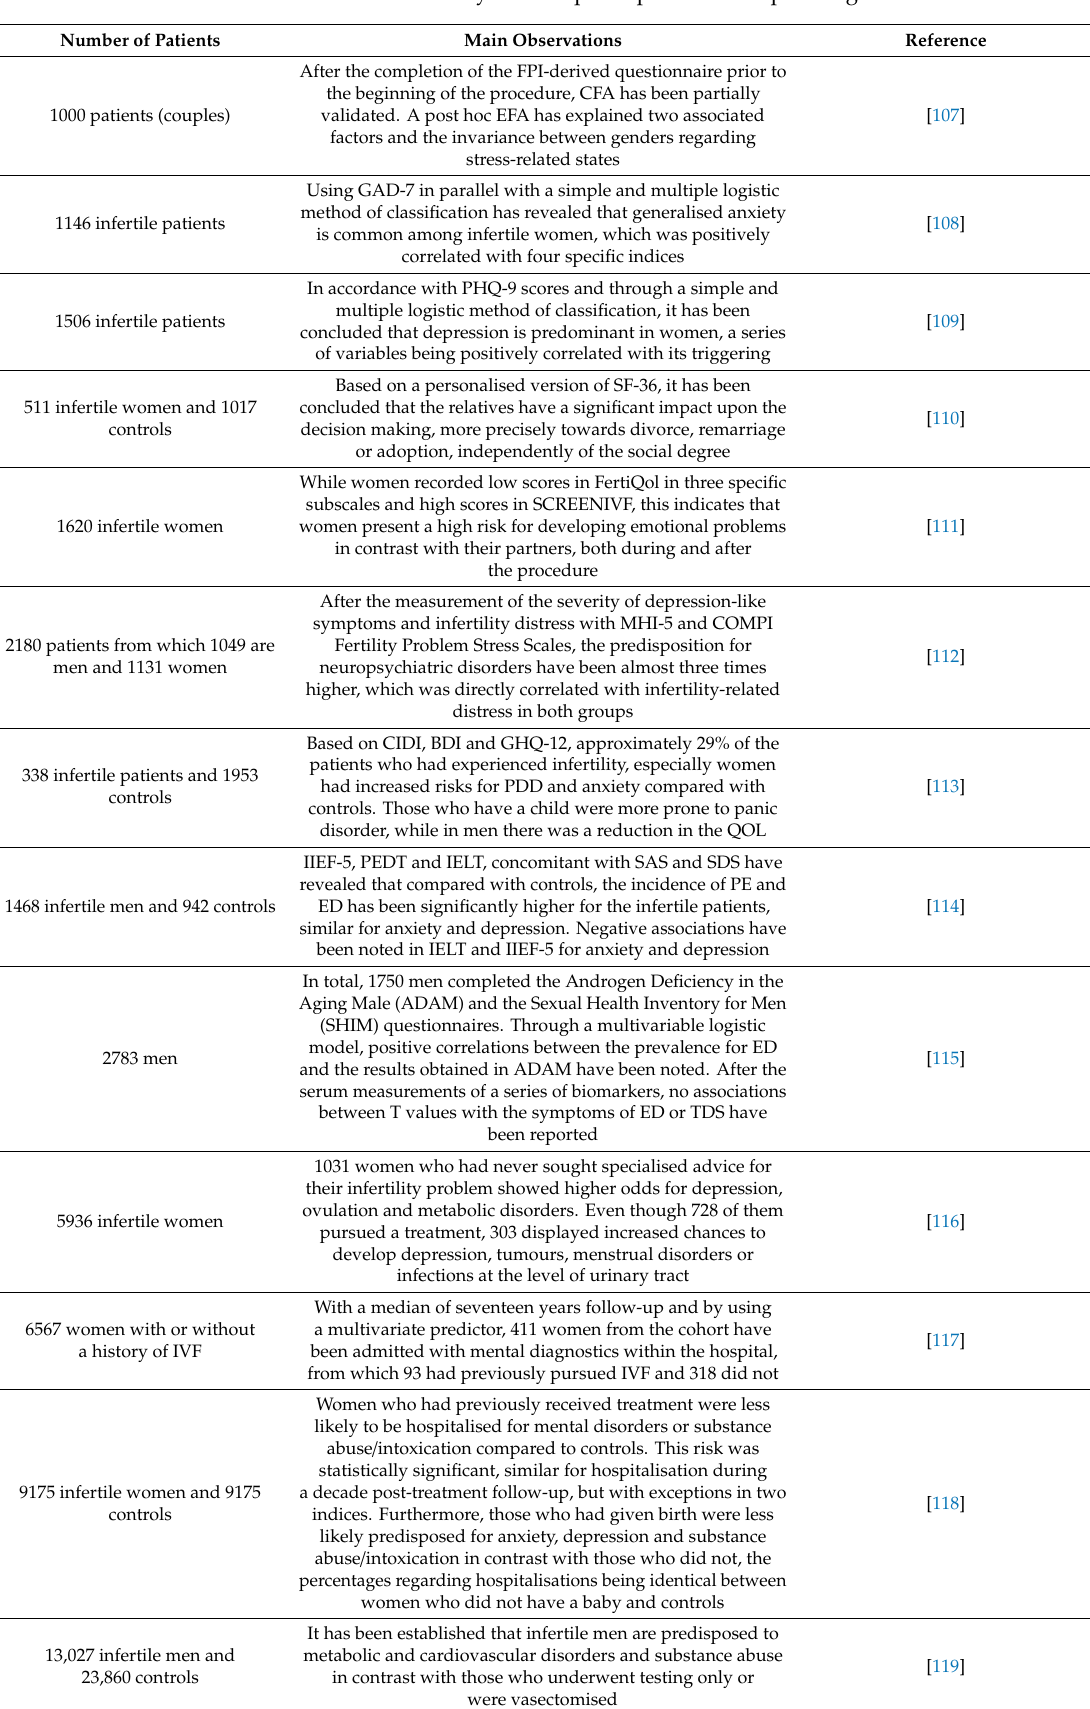
Table 3. Associations between infertility and the predisposition for upcoming health